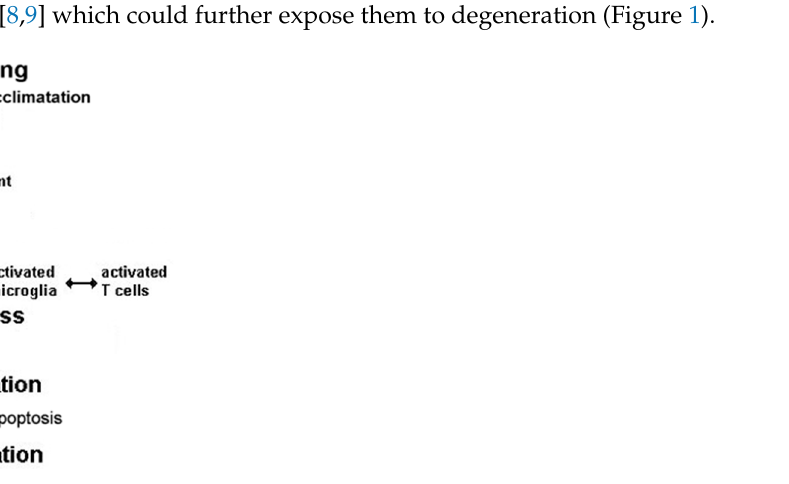
Figure 1. Graphical representation of the main events related to global warming and the possibility of occurrence of various neurodegenerative disorders.